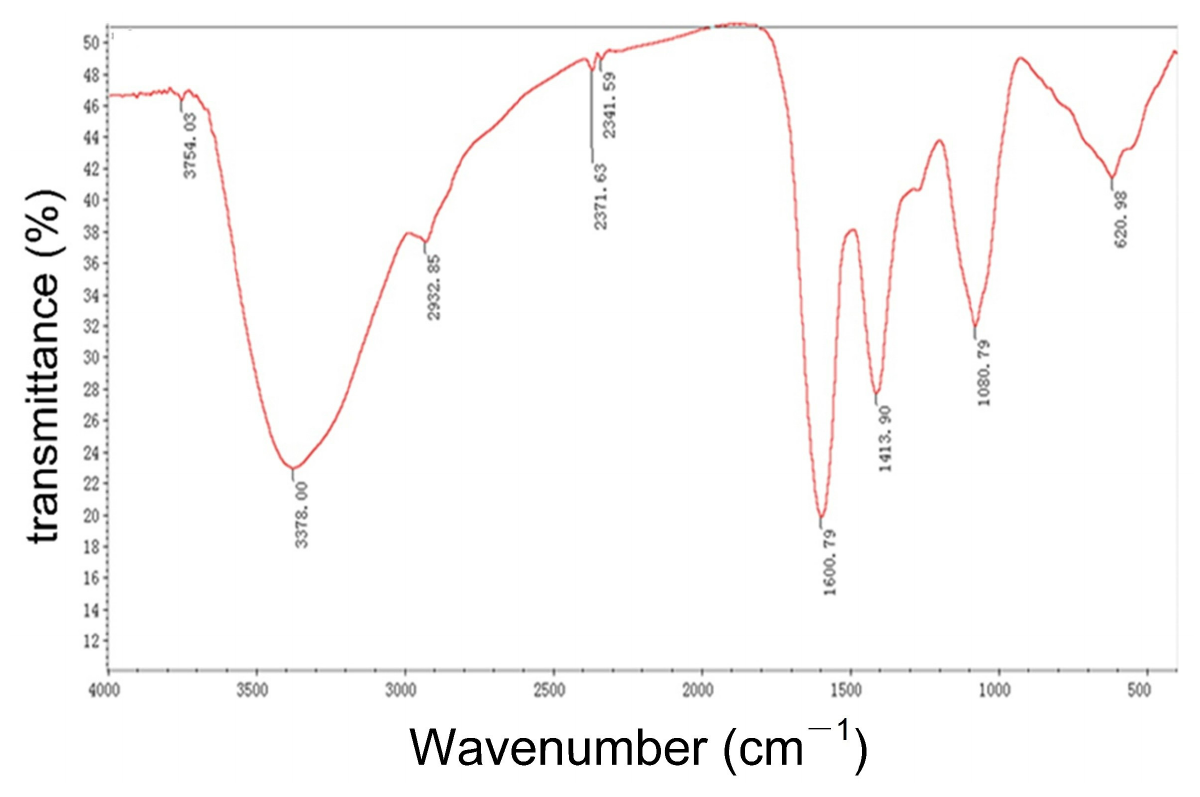
Figure 3. FT ‐ IR spectrum of